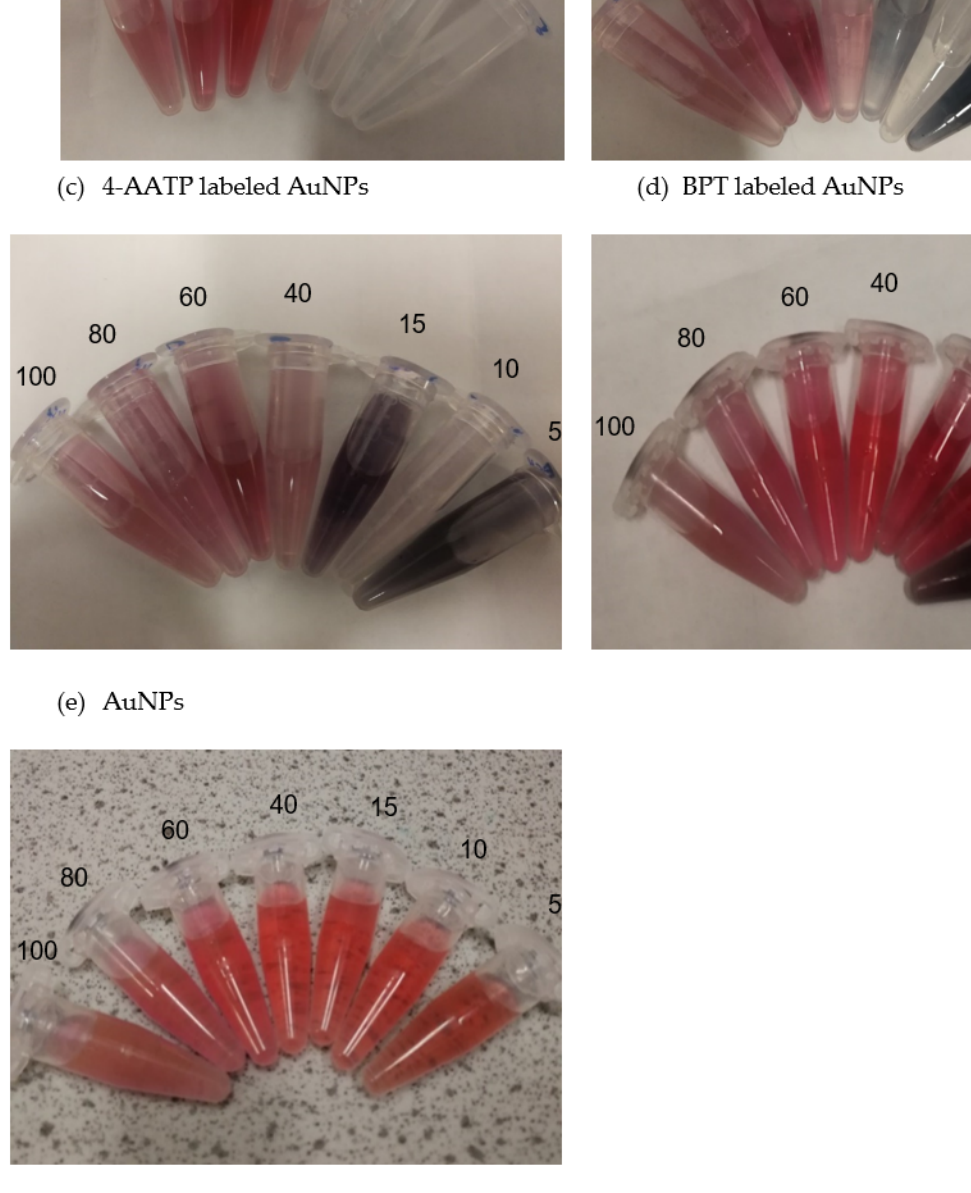
Figure 1. Solutions of AuNPs labeled with ( a ) 4-MBA, ( b ) 2-NT, ( c ) 4-AATP, ( d ) BPT, and ( e ) unlabeled AuNPs. Numbers indicate the particle size. Dark solutions in ( b – d ) denote aggregation for small-sized NPs, 15 nm and 5 nm.